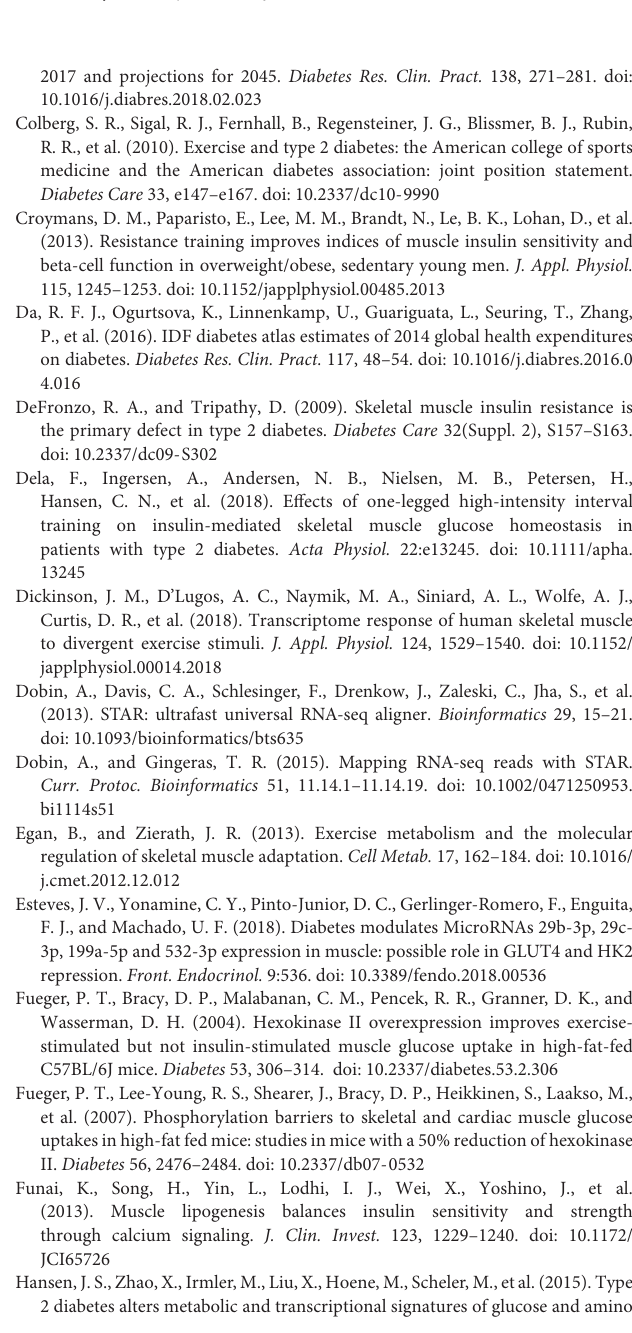
TABLE S1 | The qRT-PCR primers. TABLE S2 | The details of DEGs among the three comparisons. TABLE S3 | The GO and KEGG pathway enrichment analysis of three comparisons. TABLE S4 | Three clusters of DEGs and related KEGG pathway enrichment analysis. TABLE S5 | The TFs predicted by